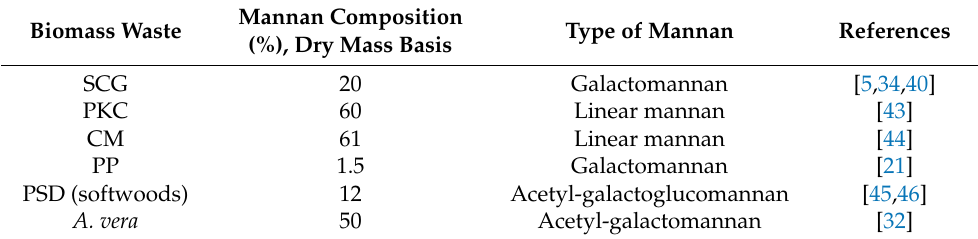
Table 1. The amount of mannan present in different biomass